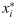
Behaviour of the structured models under weak interactions with the mean structural vector.In the first row, we plot for different values of S the envelop (the maximum and the minimal value) of the equilibrium x* among 1000 simulations. The species have been assigned a number between zero (top species) and one (basal species) corresponding to their hierarchy in the web. In the second row, the standard deviations of xi* for i = 1 (top predator), i = S/2 (intermediate) and i = S (basal) are represented as a function of S. The parameters are C = 0.25, σ = 0.4 and θ = −1. (a and b) In the cascade model, although hierarchically ordered, species tend to behave similarly with regard to convergence as S grows. The equilibrium converges almost surely to the vector 1. (c - f) The niche and the nested-hierarchy models keep the randomness of the equilibrium when S grows, even under weak interactions.